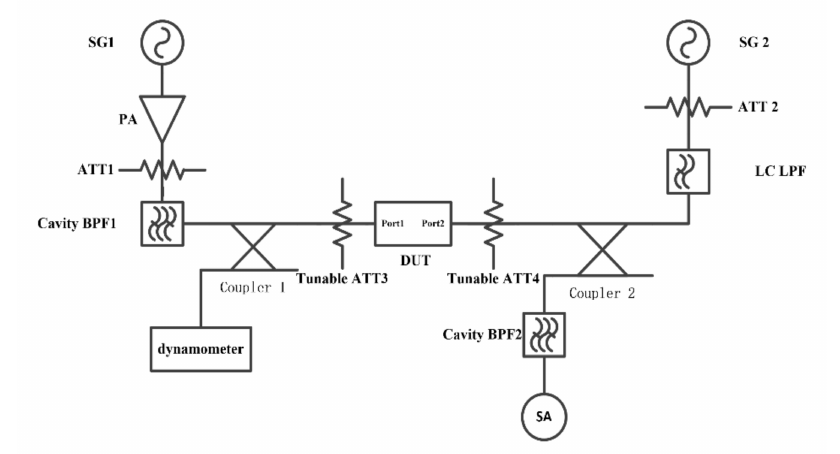
Figure 8. The nonlinear IMD2 (fTone1 + fTone2) measurement